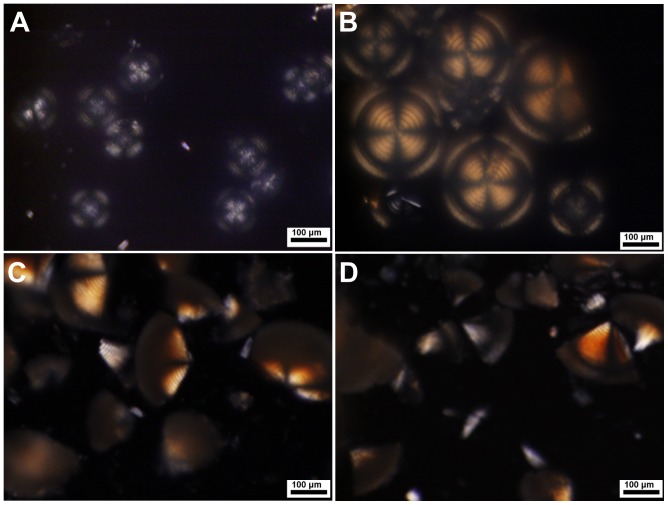
Polarized light images of magnesium carbonate microhemispheres synthesized under temperature oscillation conditions.(A) Microhemispheres synthesized from a mixture of 240 mM MgAc2, pH 6.5 with 400 mM NaHCO3 (V/V, 1∶1) at T setting of 55°C for 6 h. (B) Microhemispheres synthesized from a mixture of 240 mM MgCl2 with 500 mM NaHCO3 (V/V, 1∶1) at T setting of 55°C for 6 h. (C) and (D) Fragments of microhemispheres synthesized from a mixture same as that of (B) at T setting of 55°C for 14 h and T setting of 50°C for 14 h, respectively.